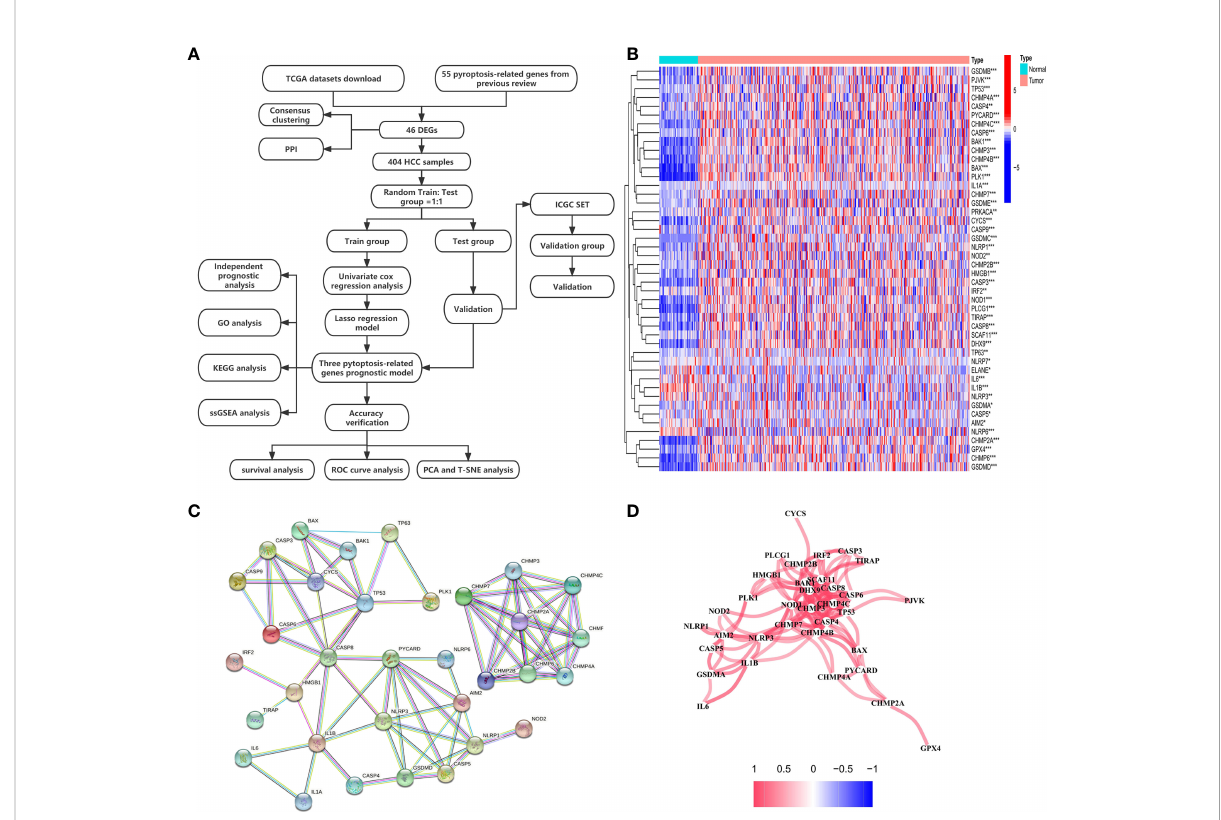
FIGURE 1 Investigation of expression levels of 46 DEGs and their mutual interactions. (A) A work fl ow diagram exhibits the whole analytic procedures. (B) A heatmap shows the expression levels of DEGs between normal and tumor tissues. * P < 0.05; ** P < 0.01; *** P < 0.001. (C) A PPI network was constructed to display the interactions of the DEGs. (D) The correlation network of the DEGs was built. Red line represented positive correlation. The depth of the colors re fl ected the strength of the